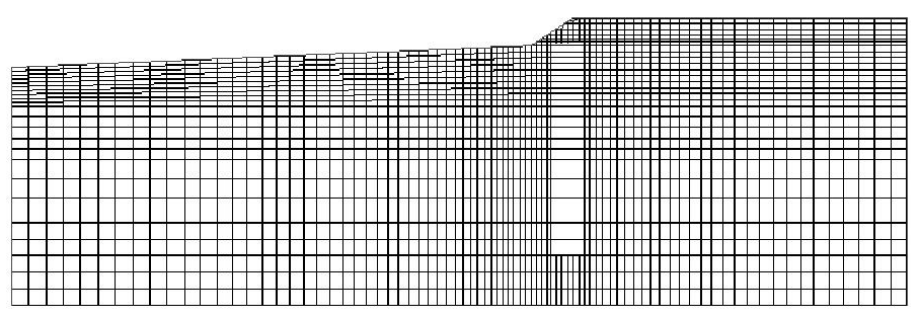
Figure 7. Computational model after meshing .